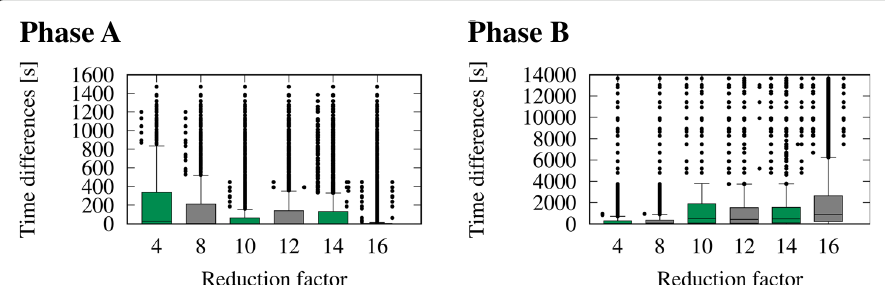
Fig. 4 Time difference between detected events and the temporally closest ground truth event for the chi square